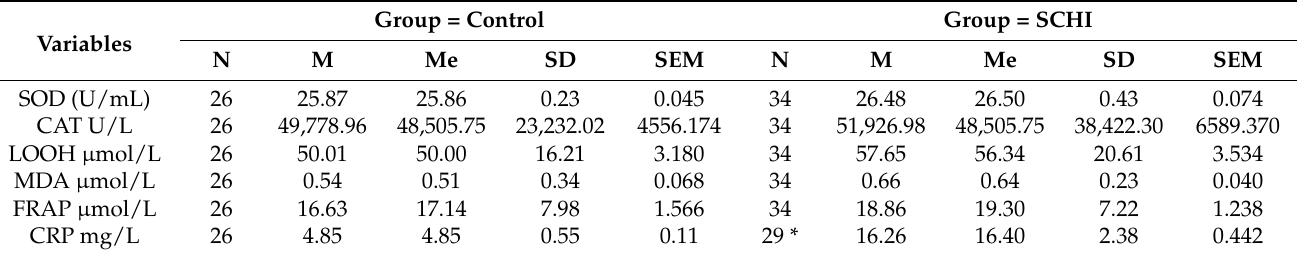
Table 1. The descriptive statistics of oxidative stress variables for the control group and patients with schizophrenia in plasma